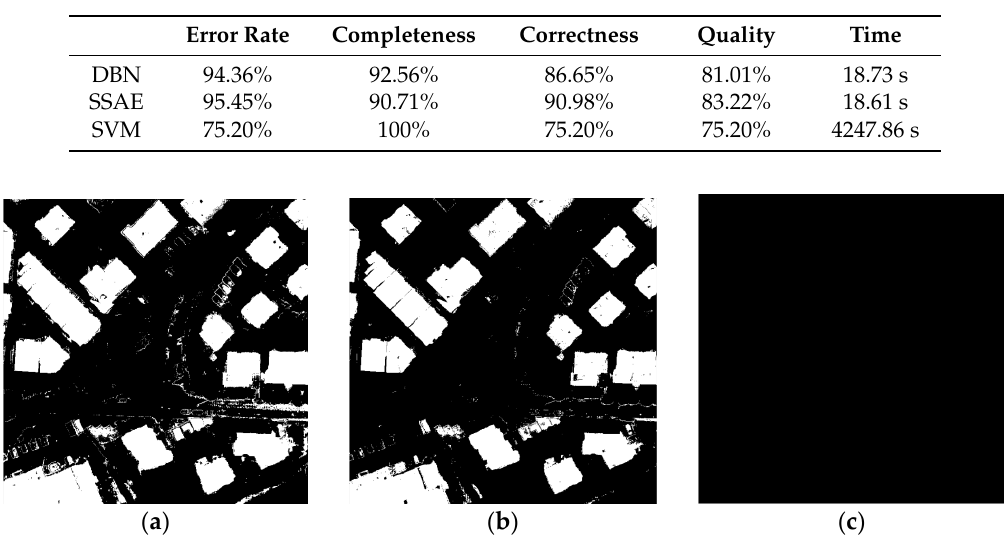
Table 6. Different methods of extraction results.